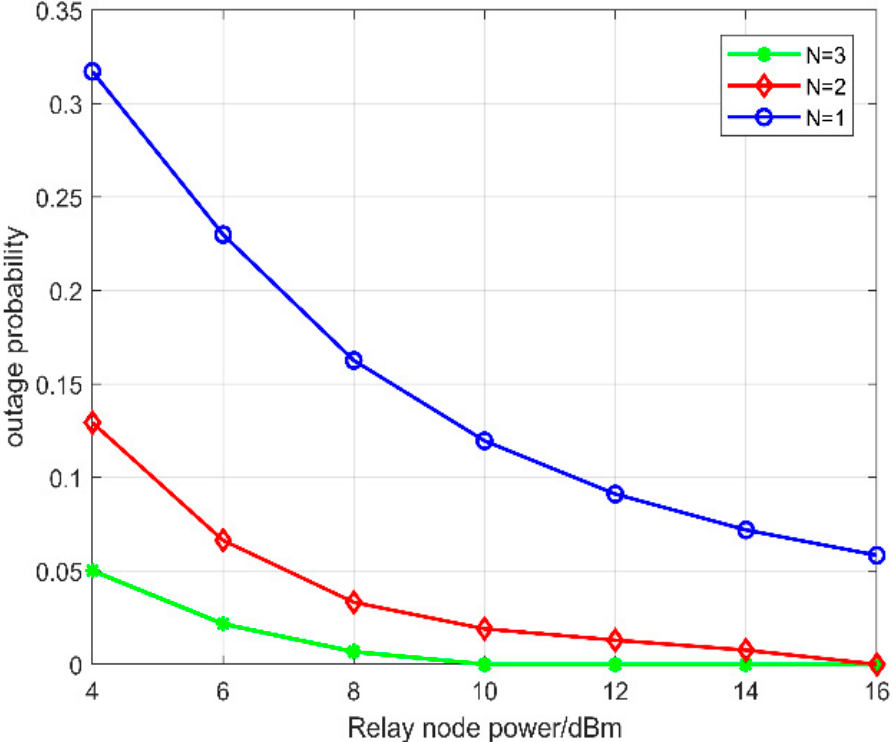
Figure 5. The relationship between system outage probability and relay power.